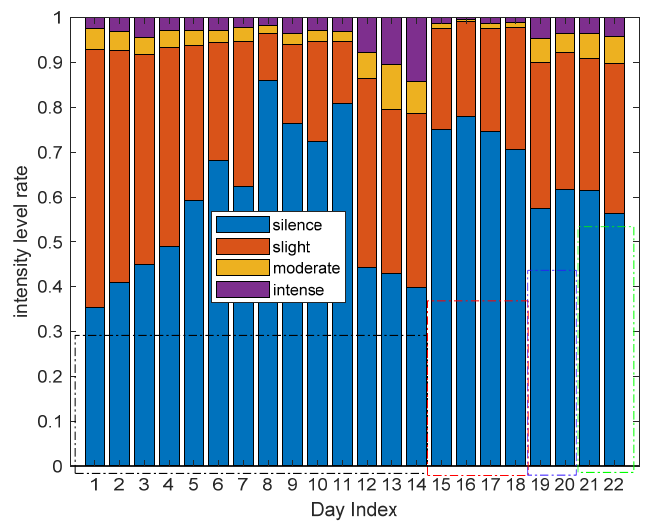
Figure 22. The activity level rate of all the volunteers in the living room.